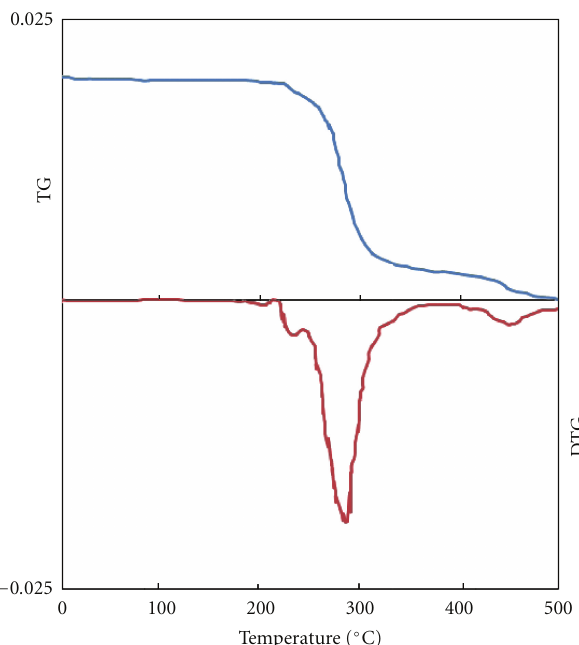
Figure 5: TG/DTG thermogram of reference sample.